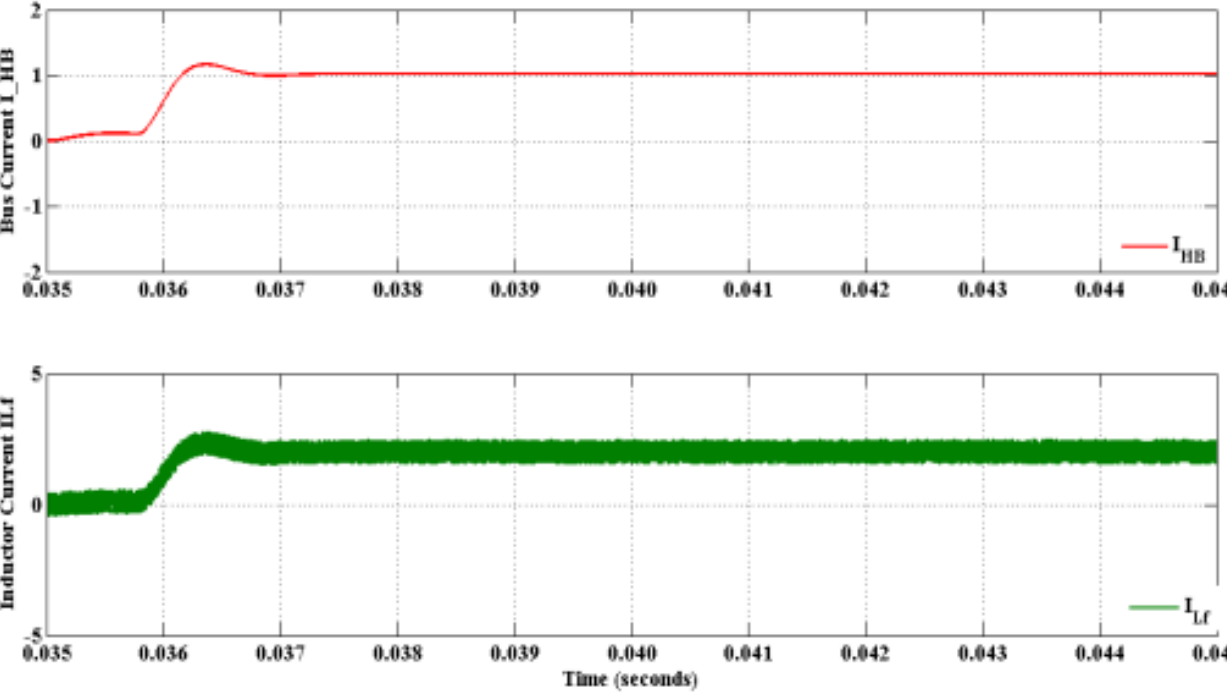
Figure 19. Regulated current step variations in inductor currents at high bus voltage. Figures 20 and 21 show the waveforms of regulated current step variations for the conceptual model for the dual low-voltage sources buck and boost modes, respectively. The higher-side current 𝑖 𝐹𝑉𝑆 and the inductor current 𝑖 𝐿𝑆 were altered to distribute en- ergy between two low-voltage source currents. Inductor current 𝑖 𝐿𝑆 and the first voltage source current 𝑖 𝐹𝑉𝑆 were controlled to transmit the power from the second voltage source